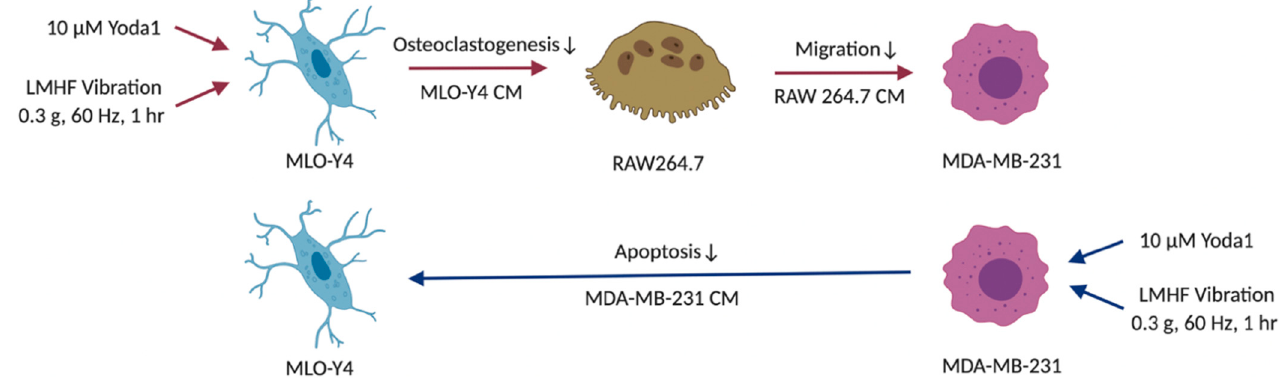
Figure 8. Indirect signaling from combined treatment stimulated osteocytes on breast cancer cells via osteoclasts, and the direct signaling of combined treatment stimulated breast cancer cells on osteocytes. Applying conditioned medium (CM) from combined treatment stimulated MLO-Y4 to RAW264.7 decreased the formation of larger and total number of osteoclasts. Further application of RAW264.7 CM reduced MDA-MB-231 migration. Moreover, the percentage of apoptotic MLO-Y4 decreased after subjecting to stimulated MDA-MB-231 CM. Figure was created using BioRender.